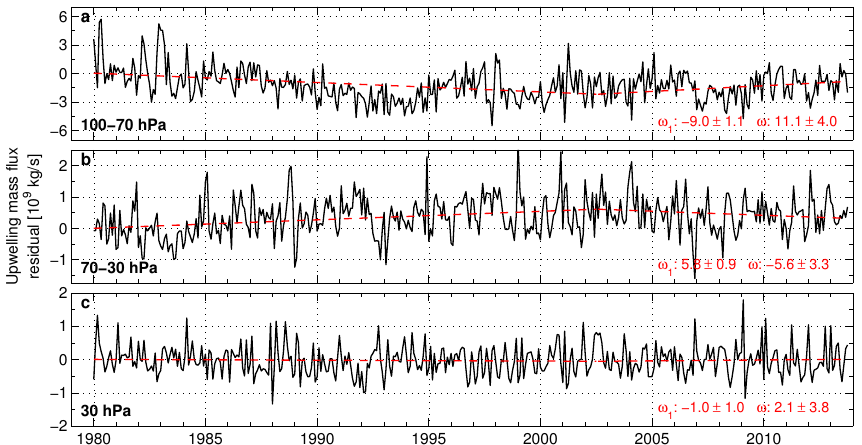
Figure 5. Fit residuals (excluding linear terms) of EI upwelling mass fluxes in different BDC branches ( a 100–70hPa; b 70–30hPa; c 30hPa). The dashed red lines depict the resulting linear trends before and after 2002 with the fit coefficients in red font (unit: % per